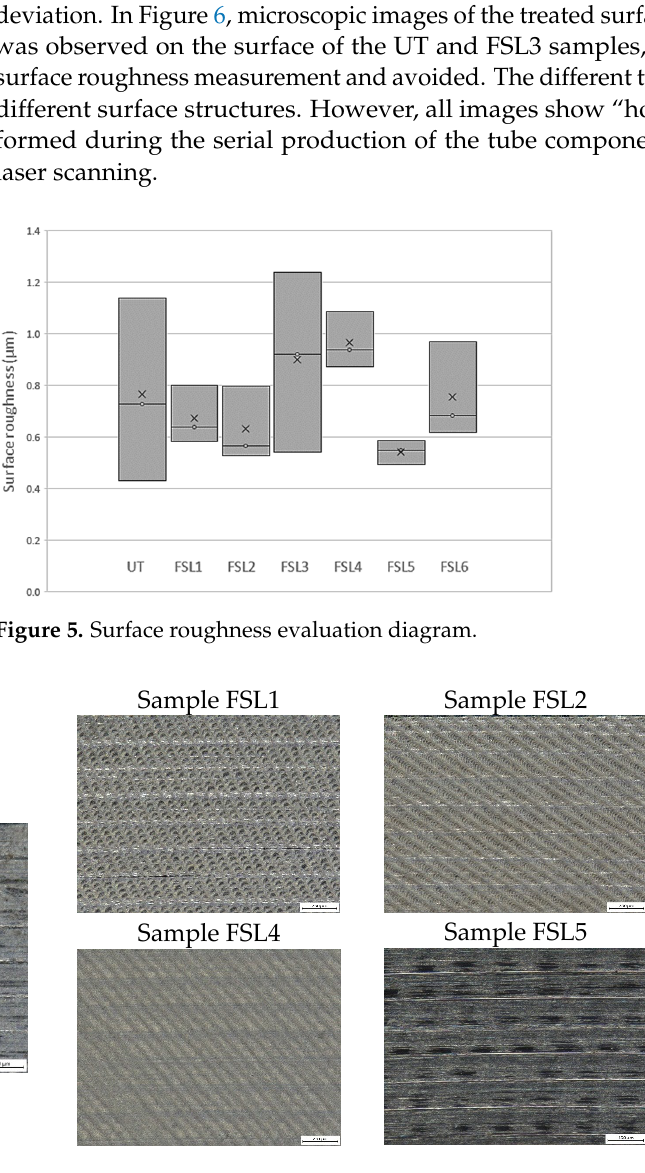
Figure 7. Recording of the drill bit.